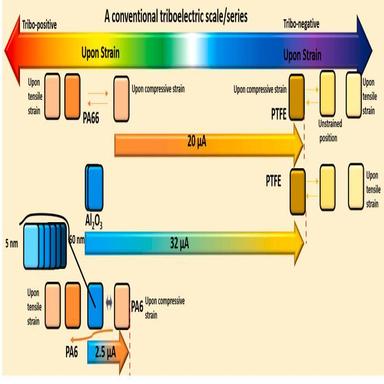
Schematic representation of the dynamic nature of materials in under-strained and unstrained conditions.